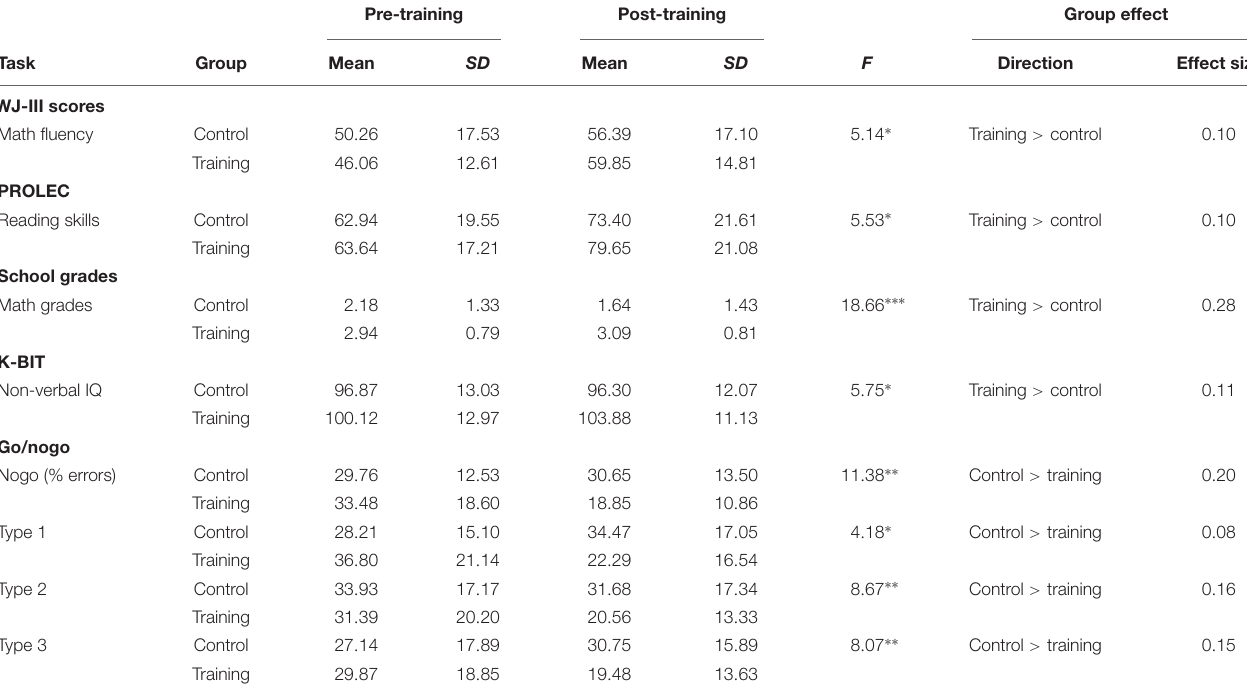
TABLE 1 | Training vs. control groups on pre- and post-training assessments: means, standard deviations, ANCOVA results (training vs. control groups), and effect sizes (partial eta squared).